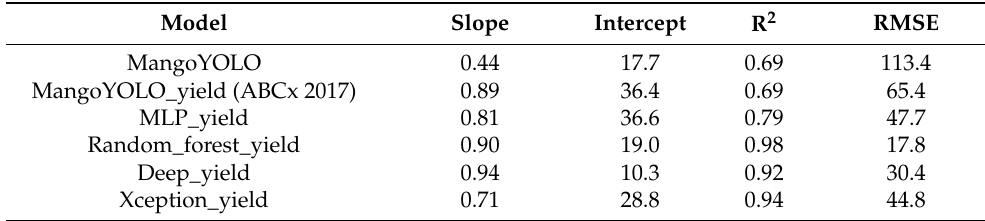
Table 11. Regression statistics for prediction of fruit load per tree, relative to human count. The result for the raw MangoYOLO prediction is included for comparison. Training set prediction results for ABC-x 2017 season sample trees using five methods, all trained with the ABCx 2017 training image set. The data set used for estimation of occlusion factor in MangoYOLO_yield method is shown in brackets. Unit for slope, bias and RMSE is #fruit/tree.